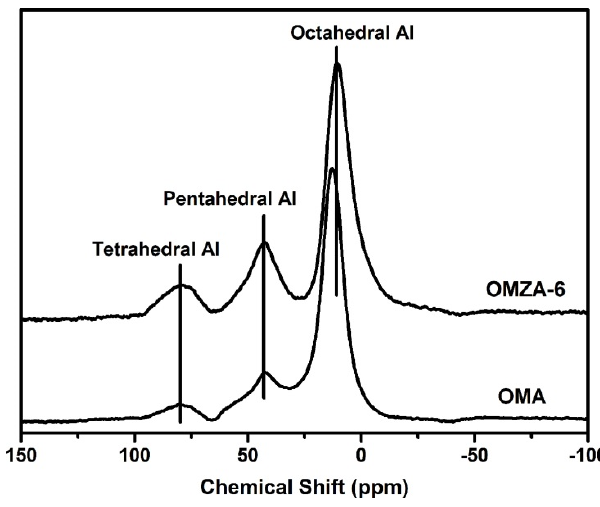
Figure 7. 27 Al MAS NMR spectra of samples OMZA-6 and OMA.